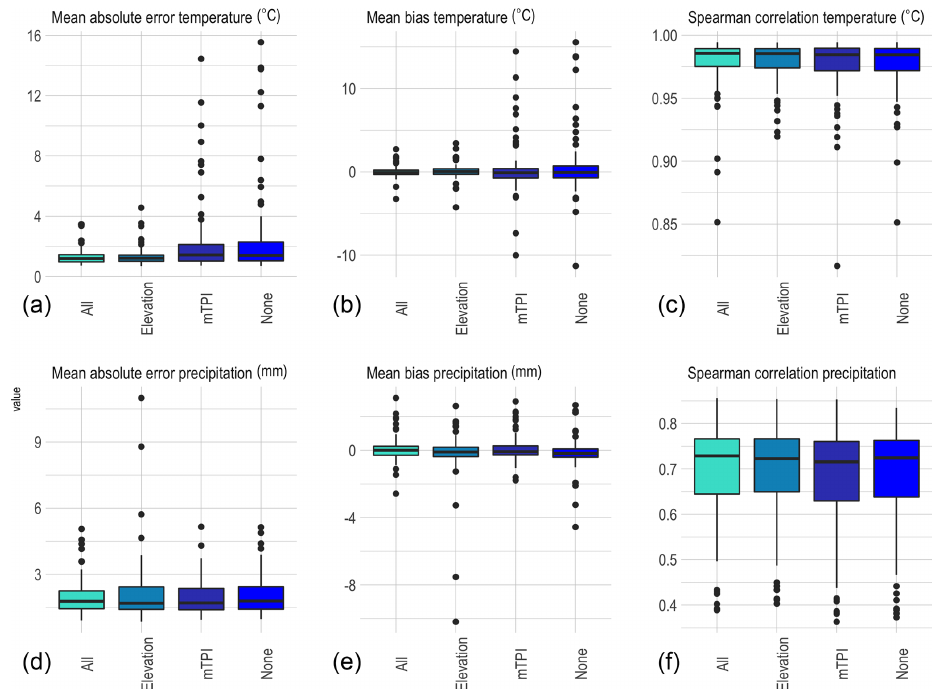
Figure 11. Comparison of model performance in the topography ablation experiment. The complete model (All) is compared to models with no topographic data (None), elevation and elevation difference only (Elevation) and mTPI only (mTPI). Boxes summarise model performance over the 86 held-out VALUE stations for maximum temperature (a–c) and precipitation (d–f) for each of the mean